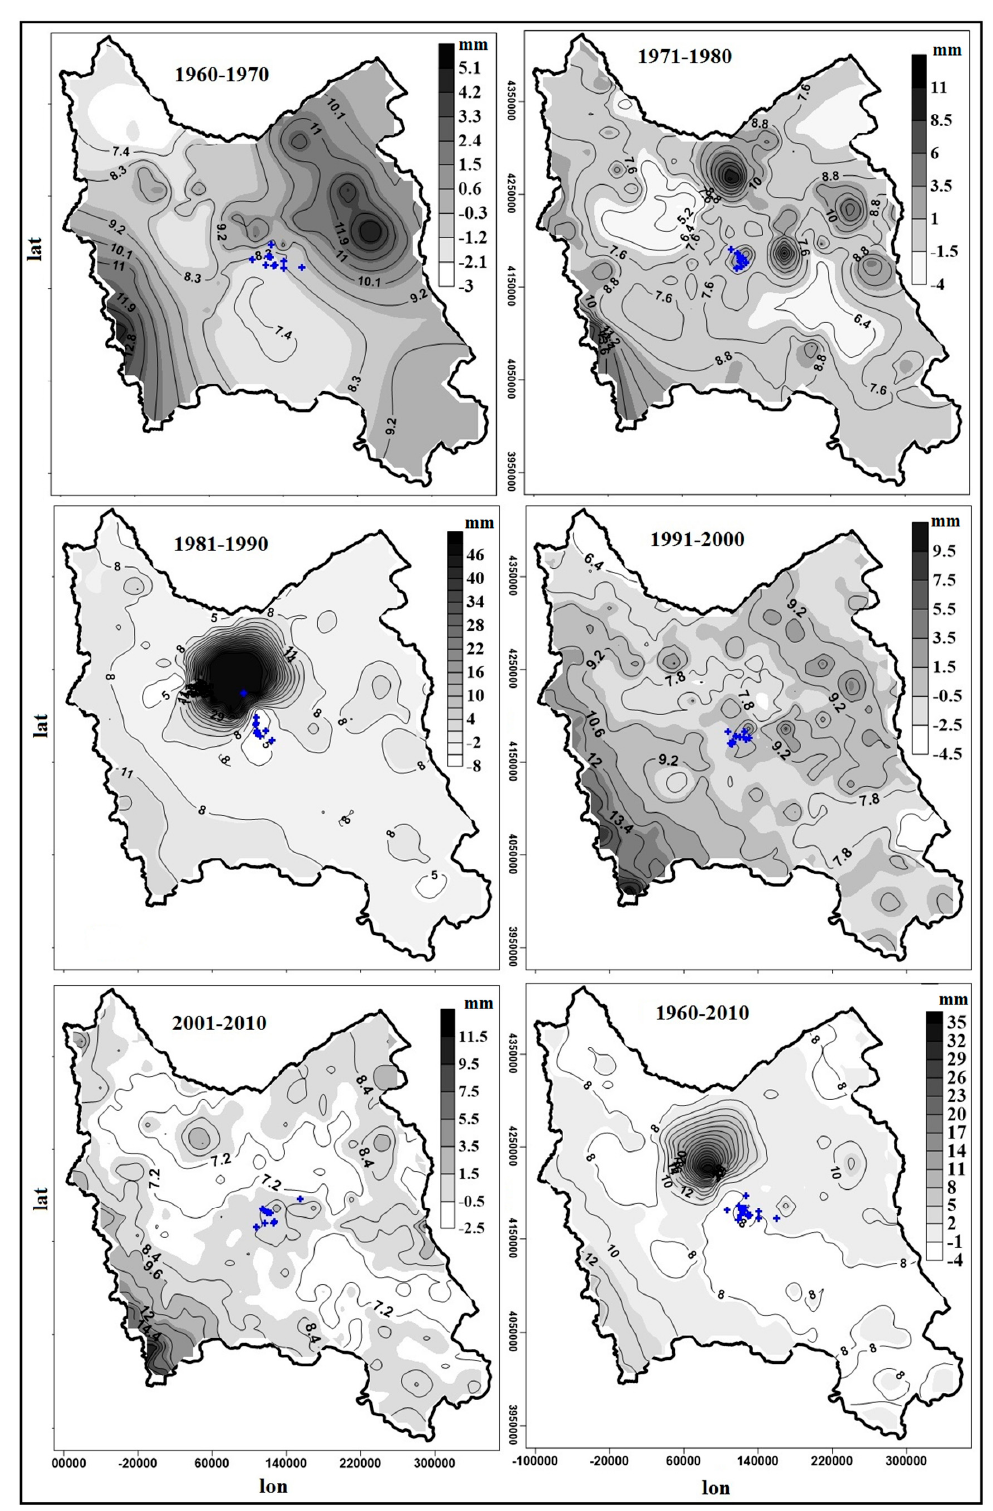
Figure 2. Spatial distribution of mean, weighted mean center, and anomalies of extreme precipitation thresholds.